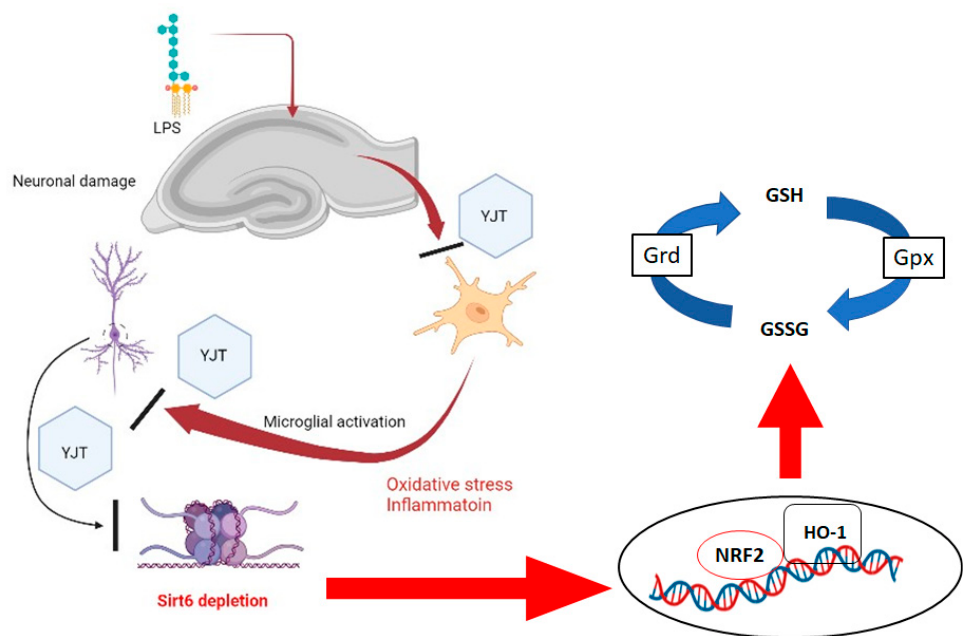
Figure 8. Summary of pharmacological effects of YJT and its underlying mechanism on LPS–induced neuroinflammation using mice model.